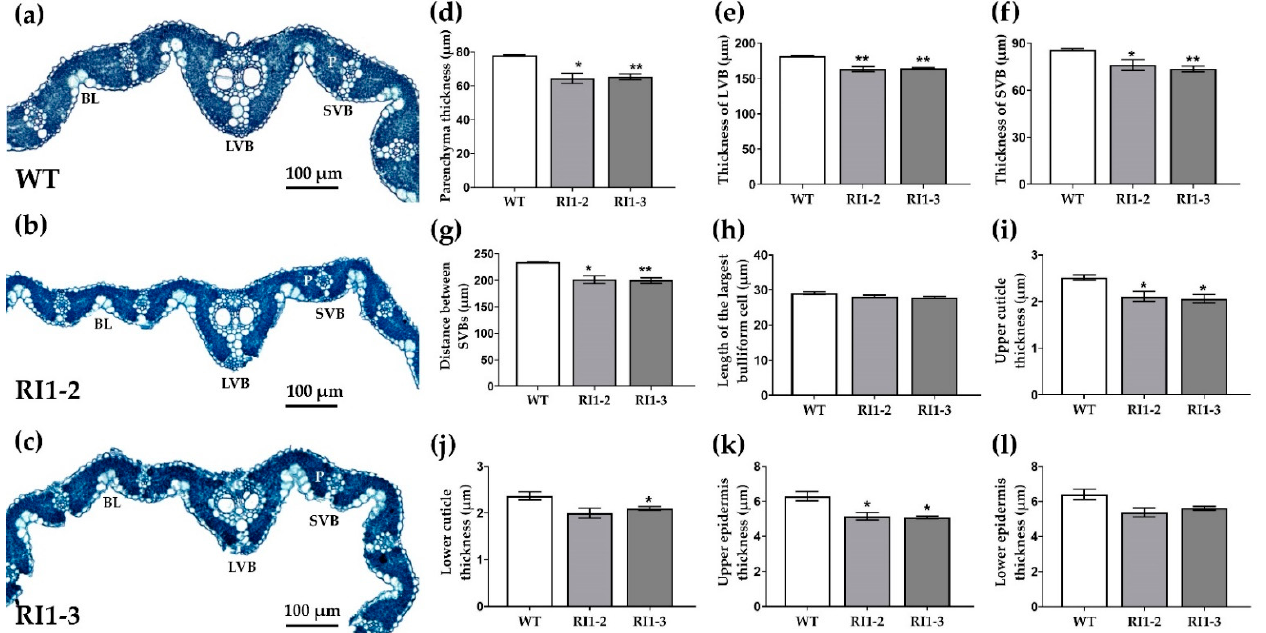
Figure 3. Leaf anatomical features of wild type (WT) and OsVTC1-1 RNAi lines. ( a ) Transverse paraffin sections of leaves from WT; ( b ) RI1-2 line; ( c ) RI1-3 line. ( d ) Parenchyma thickness; ( e ) Thickness of large vascular bundle (LVB); ( f ) Thickness of small vascular bundle (SVB); ( g ) Distance between adjacent SVBs; ( h ) Length of the largest bulliform cell; ( i ) Upper cuticle thickness; ( j ) Lower cuticle thickness; ( k ) Upper epidermis thickness; ( l ) Lower epidermis thickness. BL, bulliform cells; LVB, large vascular bundle; P (white color), parenchyma; SVB, small vascular bundle. Bars represent the means and standard errors of three replicates. Asterisk indicates statistically significant differences from wild type analyzed using Student’s t -test (* p < 0.05, ** p < 0.01) .